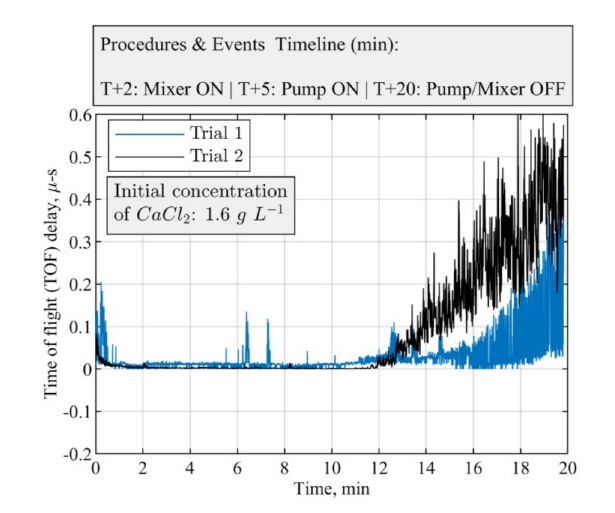
Figure 10. USCT measurement of the reactive crystallization process: mixing speed of 100 RPM and feed addition rate of 40 mL min − 1 . Mean value of sound speed measured for two identical crystallization